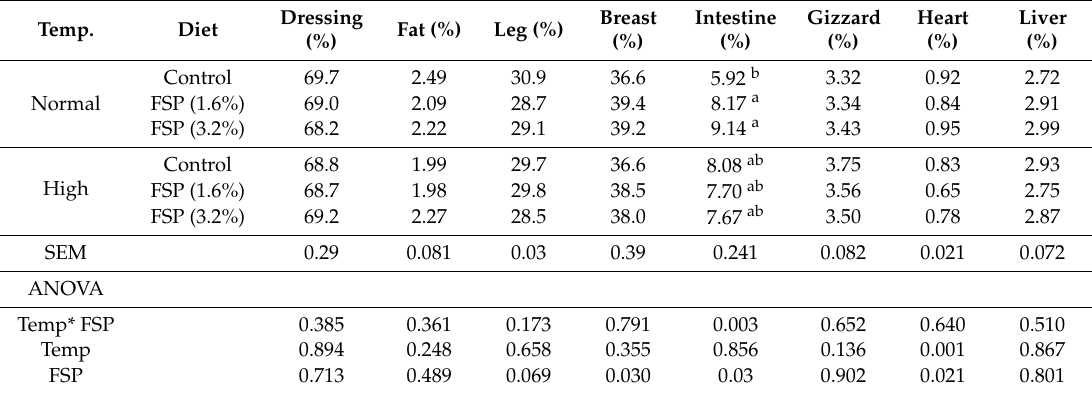
Table 3. Carcass characteristics a ff ected by supplementation with fennel seed powder under thermoneutral or heat stress